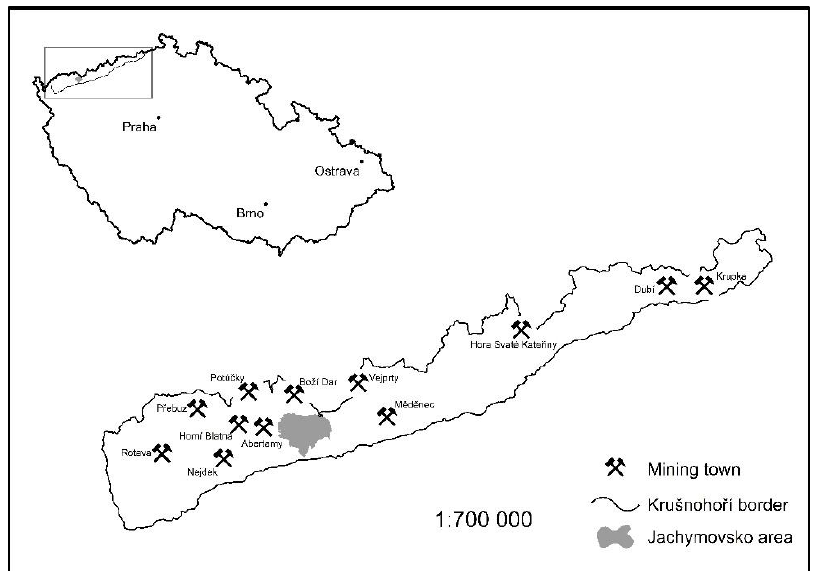
Figure 1. Location of the area of interest within the Krušnohoří /Erzgebirge and within the Czechia. Source: author; own elaboration.